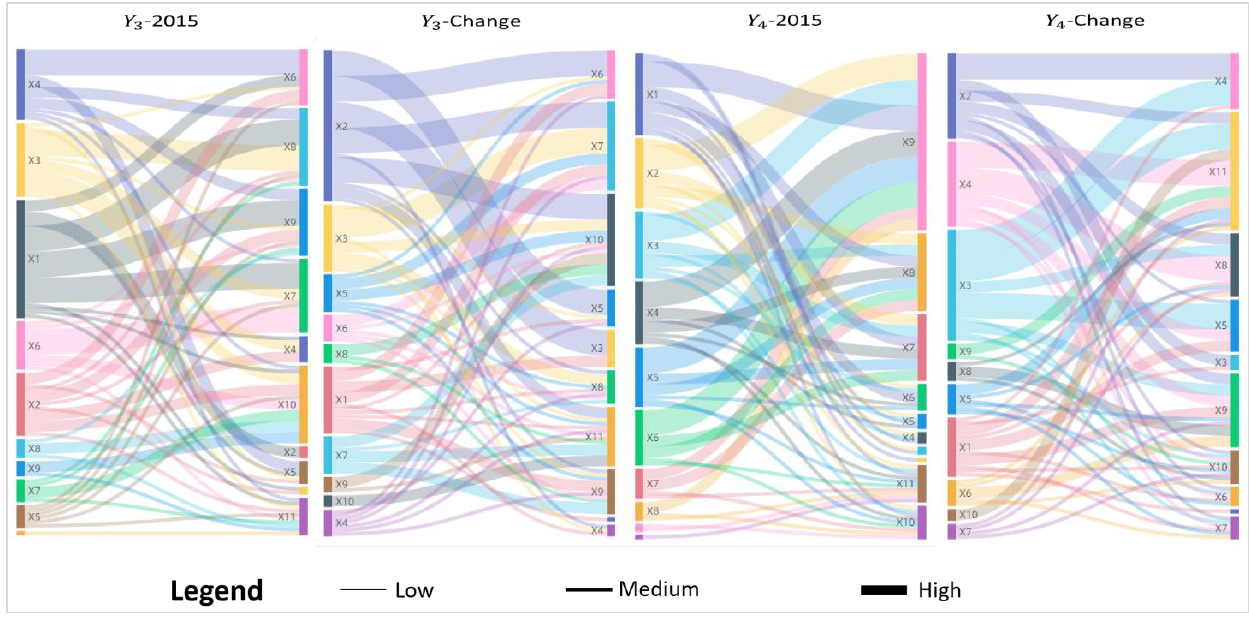
Figure 9. Interaction detector analysis of night light data changes in Guangxi .